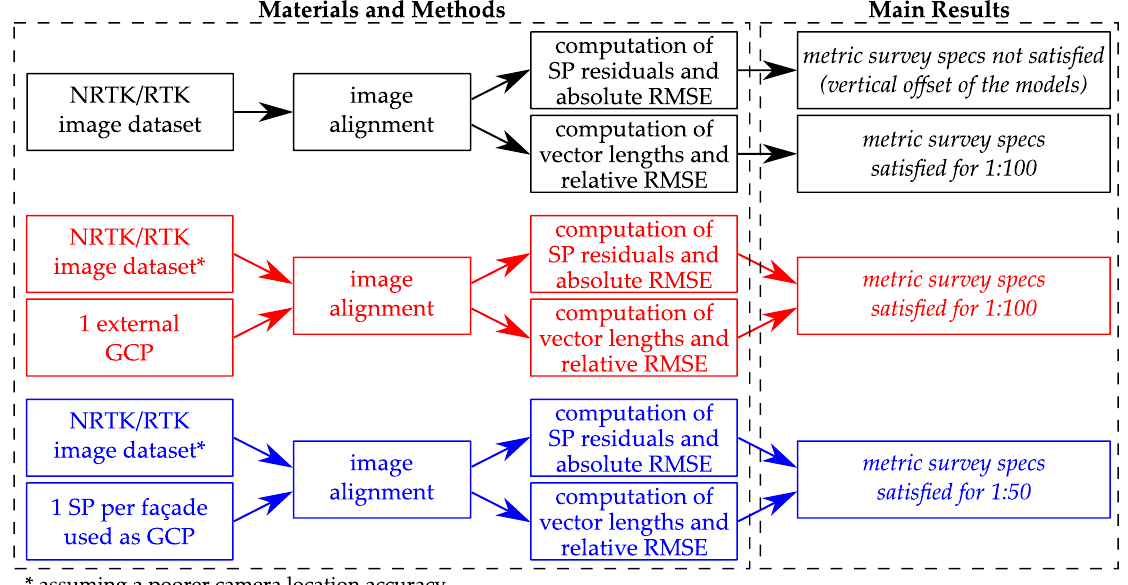
Figure 13. Main workflow and results obtained in this